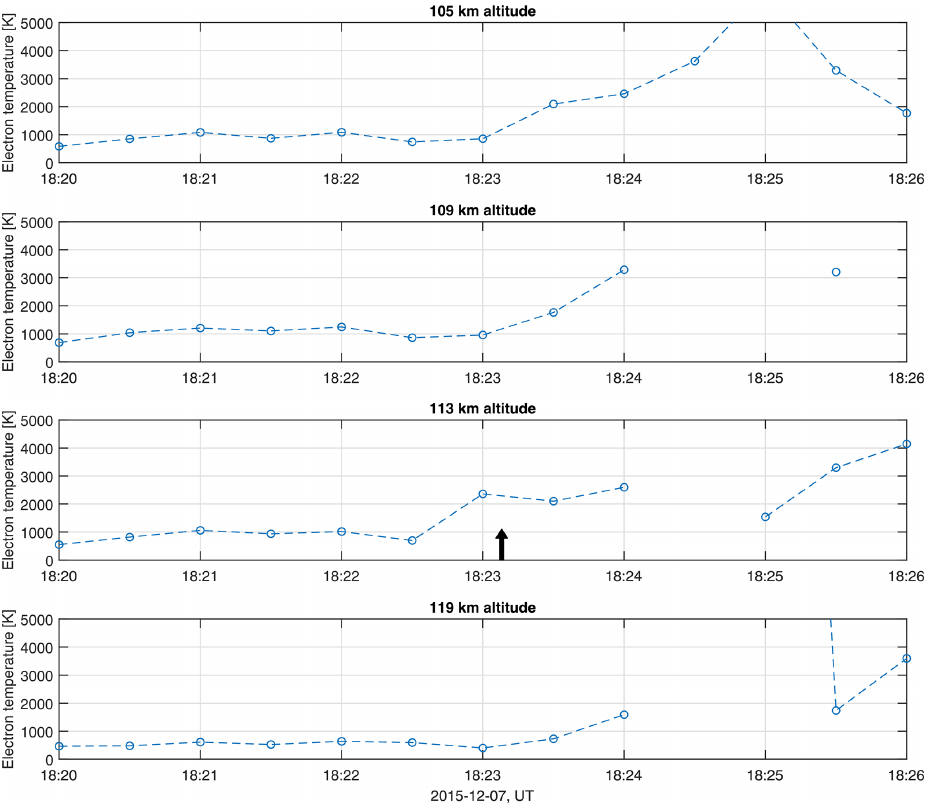
Figure 7. Time series of electron temperatures at four successive altitudes between 105–119km from incoherent scatter data from the ESR (analysed with GUISDAP) for 18:20–18:26UTC on 7 December 2015. Data points with errors > 50% of the values were removed. The arrow marks the time of the FAE passing and denotes the distinct increase in electron temperature specifically at